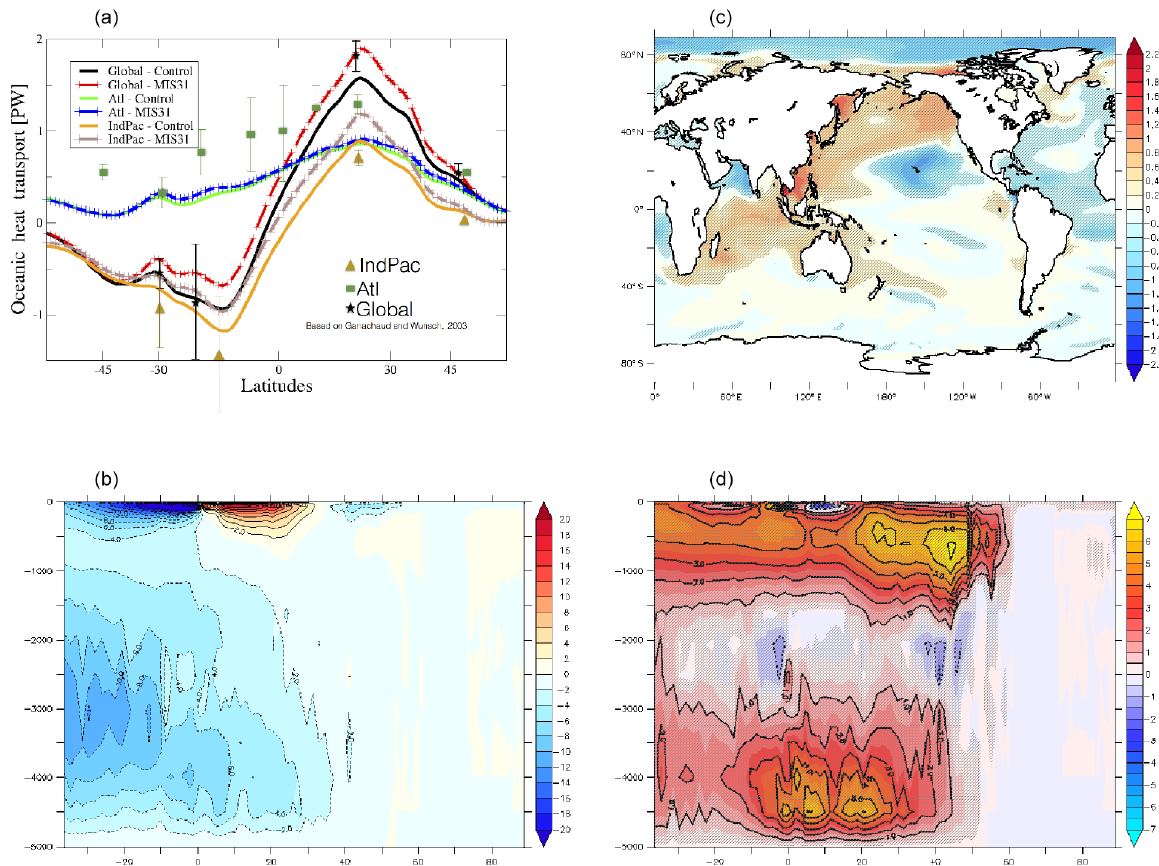
Figure 4. (a) Time-averaged OHT (PW) for CTR (solid line) and MIS31 (dashed-crossed line). Stars, squares, and triangles show estimates based on Ganachaud and Wunsch (2003). (b) Pacific Meridional Overturning Circulation (PMOC) in the CTR. (c) Sea surface salinity differences between MIS31 and CTR. (d) Differences between the MIS31 and CTR PMOC. The hatched regions in panels (c) and (d) are significant at 95% based on t -test